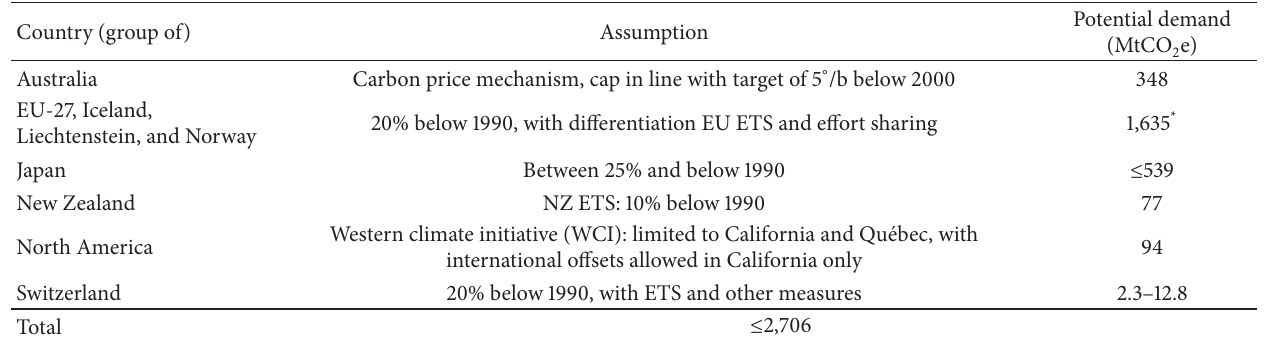
Table 2: Demand forecast of national carbon offset in non-Annex I countries during the period 2013–2020 [13]. Country (group of) Assumption